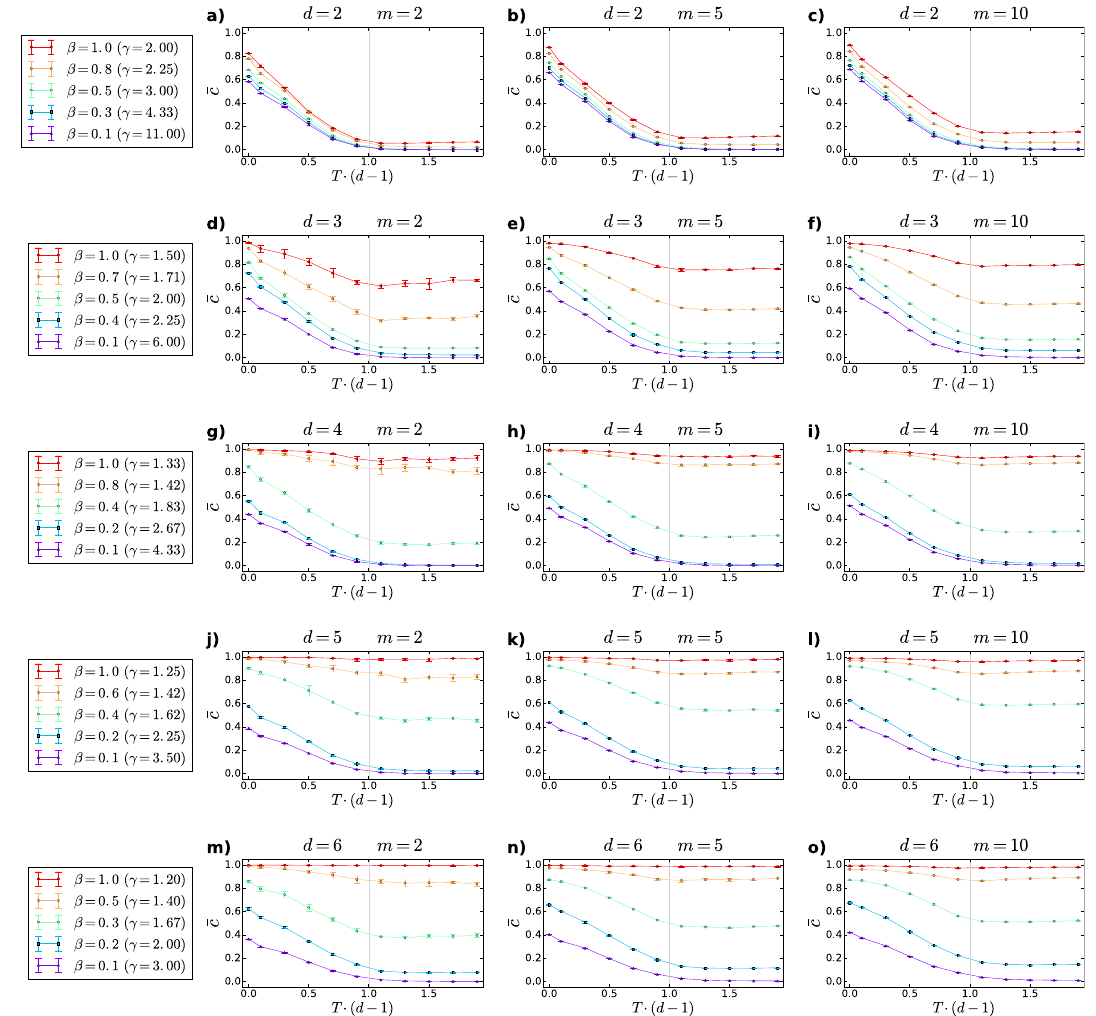
c of d PSO networks as a function of the rescaled temperature Figure 3. Average clustering coefficient ¯ T 1 ) . Each row of panels (i.e., panels a – c , d – f , g – i , j – l and m – o ) was created using a given dimension d , ( d · − and each column of subplots presents the results obtained with a given value of the expected average degree 2 m , as written in the panel titles. The different curves of each panel correspond to different values of the popularity fading parameter β (yielding different degree decay exponents γ ), listed for each dimension in the leftmost panel of the corresponding row. The displayed data points were obtained by averaging over 5 d PSO networks generated independently with a given set of model parameters, setting the number of nodes to 10, 000 and the 1 in each case. The error bars show the standard deviations measured curvature of the hyperbolic space to − 1 /( d 1 ) among the 5 networks. The grey vertical lines indicate the critical point T c = −